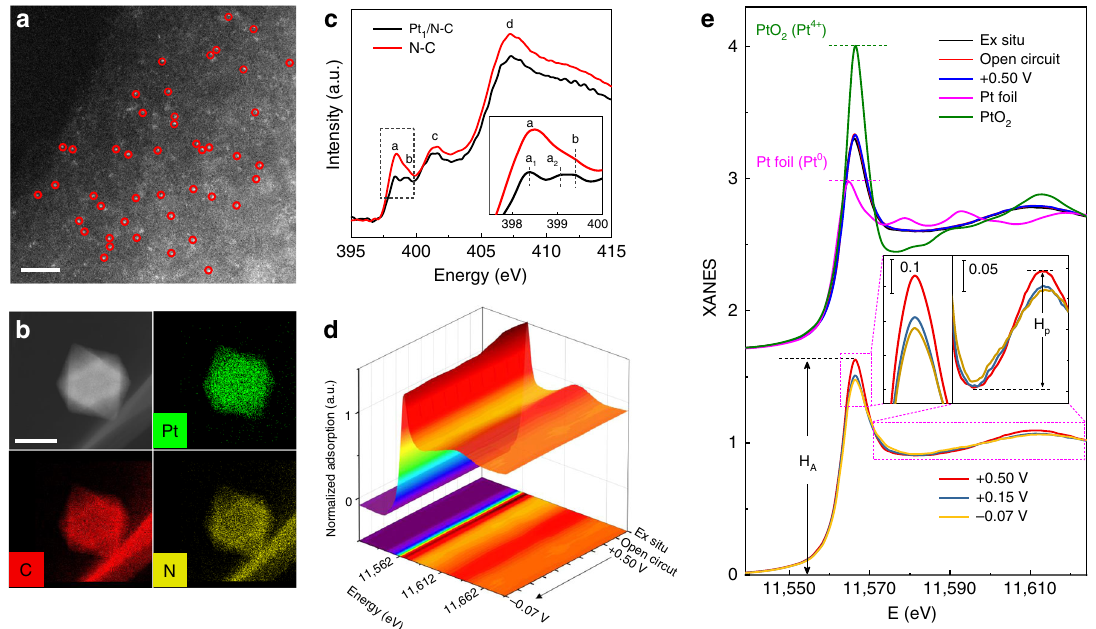
Fig. 1 Microstructure and operando XANES characterization. a Atomic-resolution HAADF – STEM image of Pt 1 /N-C, showing that only Pt single atoms are present (marked by red circles). Length of scale bar is 2 nm. b Micromorphology and elemental mapping of Pt 1 /N-C. Length of scale bar is 200 nm. c N K- edge XANES spectra of N-C framework (before ALD) and Pt 1 /N-C (after ALD). d Three-dimensional pro fi le plot of successive operando Pt L 3 -edge XANES spectra acquired in different conditions. e Selected XANES spectra in d at different applied voltages from the open-circuit condition to − 0.07 V during HER, and the XANES data of the reference standards of Pt foil and PtO 2 . Inset, Magni fi ed white-line peak and post-edge XANES